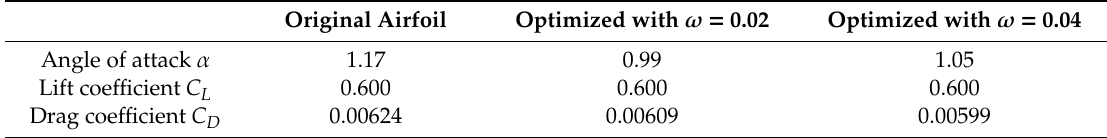
Table 4. Transition computations of the airfoils ( Ma = 0.73, Re = 6.5 × 10 6